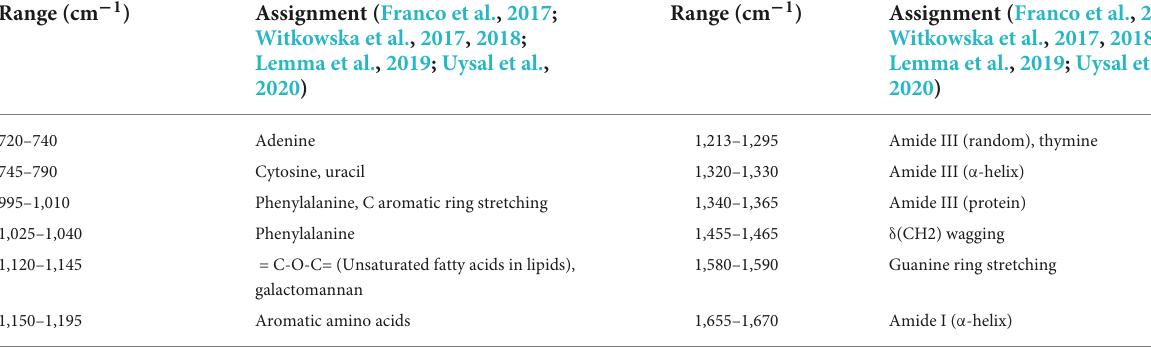
TABLE 1 Raman spectral peak assignment observed in the spectra of six bacterial strains.